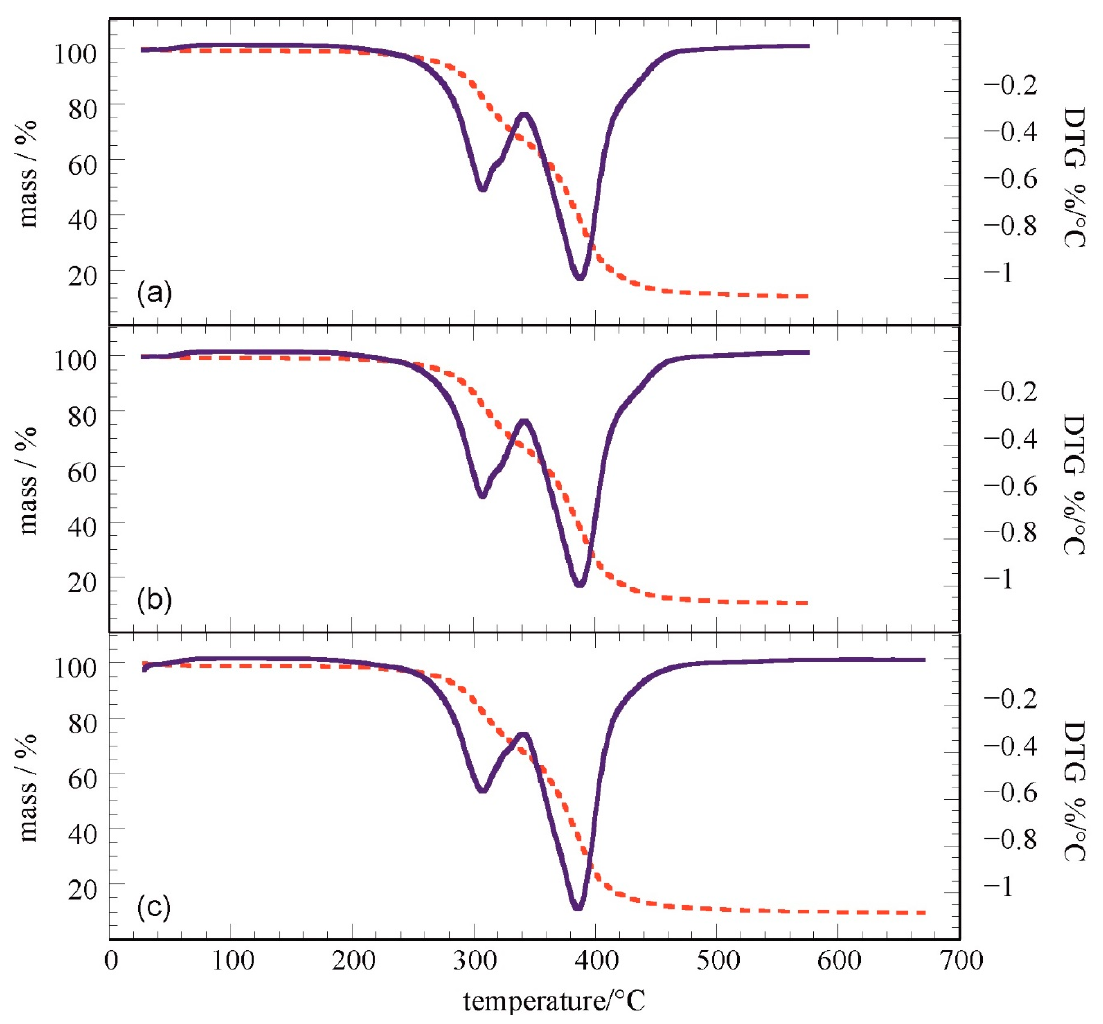
Figure 15. Thermogravimetric curves for ( a ) PU, ( b ) PU-0.2%MWCNT, and ( c ) PU-0.4%HFNS films.